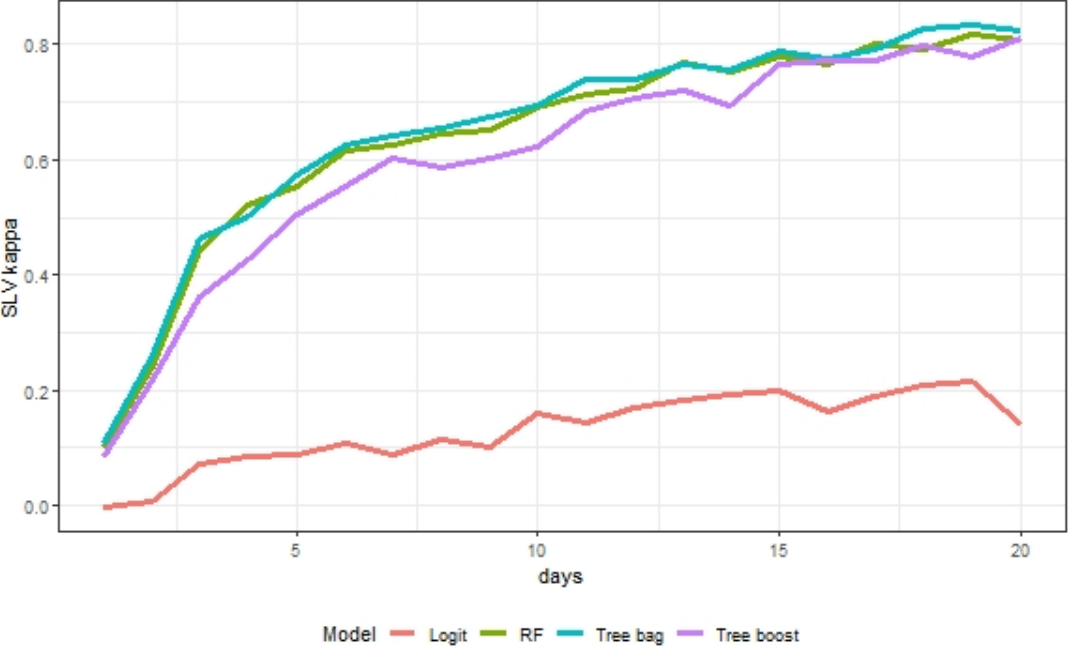
Figure 7. This figure shows the multi-period kappa accuracy for SLV price direction. In order to determine which variables are most important in the RFs method, variable importance measures are provided. Variable importance is ascertained by using the mean decrease in accuracy (MD accuracy) and the mean decrease in Gini (MD Gini). The OOB data are used to conduct the analysis. For each of GLD and SLV at a 10-period forecast horizon, MA200, MA50, and WAD are the three most important features in classifying gold and silver price direction because they have the largest values of MD accuracy and MD Gini (Table 2). In additional analysis MA200, MA50, and WAD are also important features in classifying gold and silver price direction for other forecast